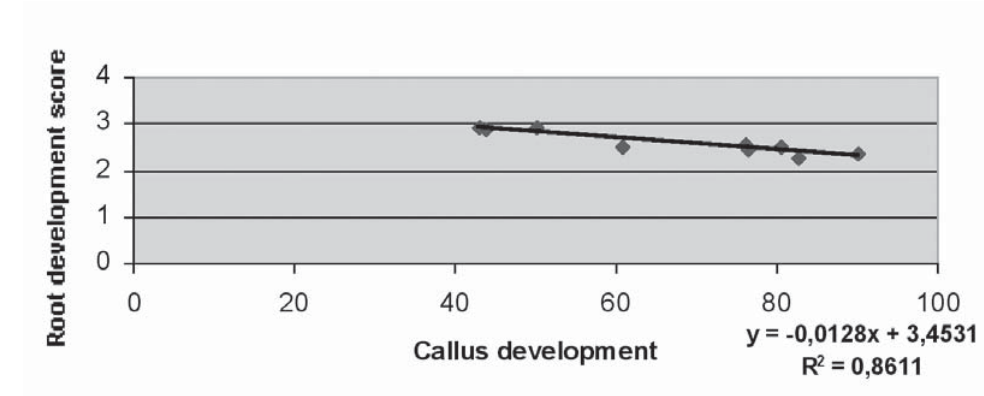
Fig. 2. Cultivar Cabernet Sauvignon regression plot – root development versus callus development.